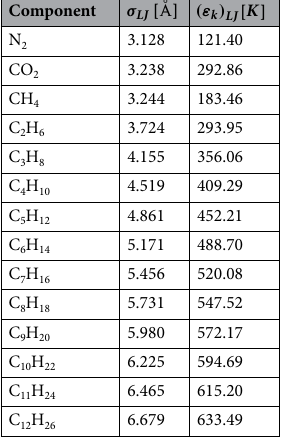
Table 4. Adjusted L-J parameters of nitrogen, carbon dioxide, and light to semi-heavy normal alkanes.